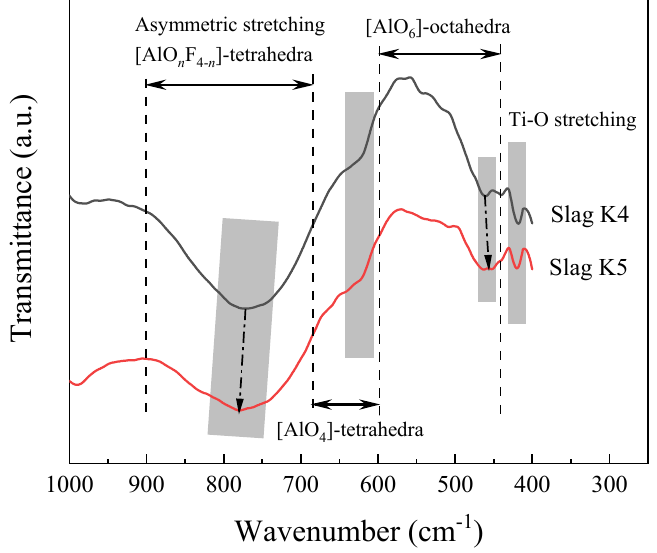
Figure 7. FTIR spectra for the slags of K4 and